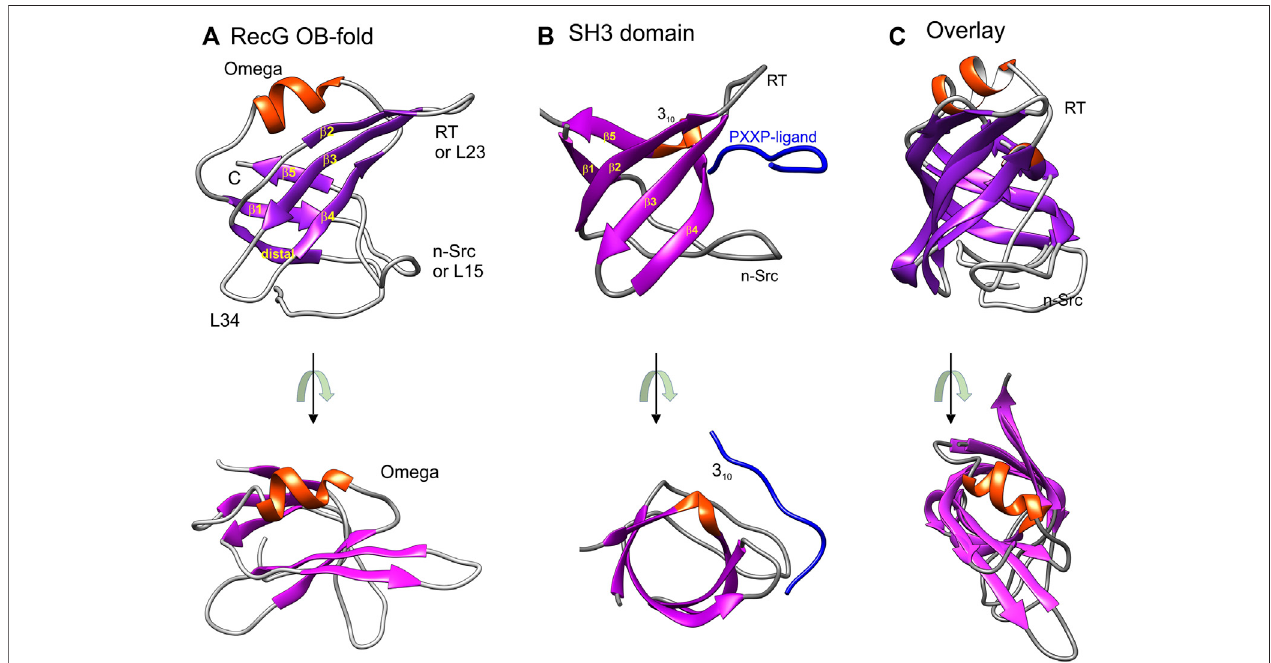
FIGURE1| OB-foldsandSH3domainsarestructurallyalmostidentical.ImagesweregeneratedusingChimerawithhelicescoloredredand β -sheetsinpurple. (A) The OB-fold is from the T. maritima RecG (PDB fi le:1GM5) (Singleton et al., 2001). (B) The SH3 domain bound to a PXXP-ligand (blue) shown is from the ABL tyrosine kinase (PDB fi le: 1ABO) (Musacchio et al., 1994). The labeling of strands, helices, and loops in panels A and B is taken from reference (Agrawal and Kishan 2001). Loop nomenclatureisfromtheSrcprotein(RT-SrcandnSrc,respectively)(Yuetal.,1992).TheRT-loopconnects β 2and3(L23)whilethenSrcloopconnects β -strands 1 and 5 (L15). (C) Structural alignment of an SH3 domain (PDB fi le:2XKC) and with the RecG OB-fold. The alignment was done using TM-align (Zhang and Skolnick, 2005). This fi gure was adapted from (Bianco, 2021). In the images at the bottom of panels (A – C) , the representative OB-fold and SH3 domains are rotated towards the viewer so that the β -barrels can be viewed from the top